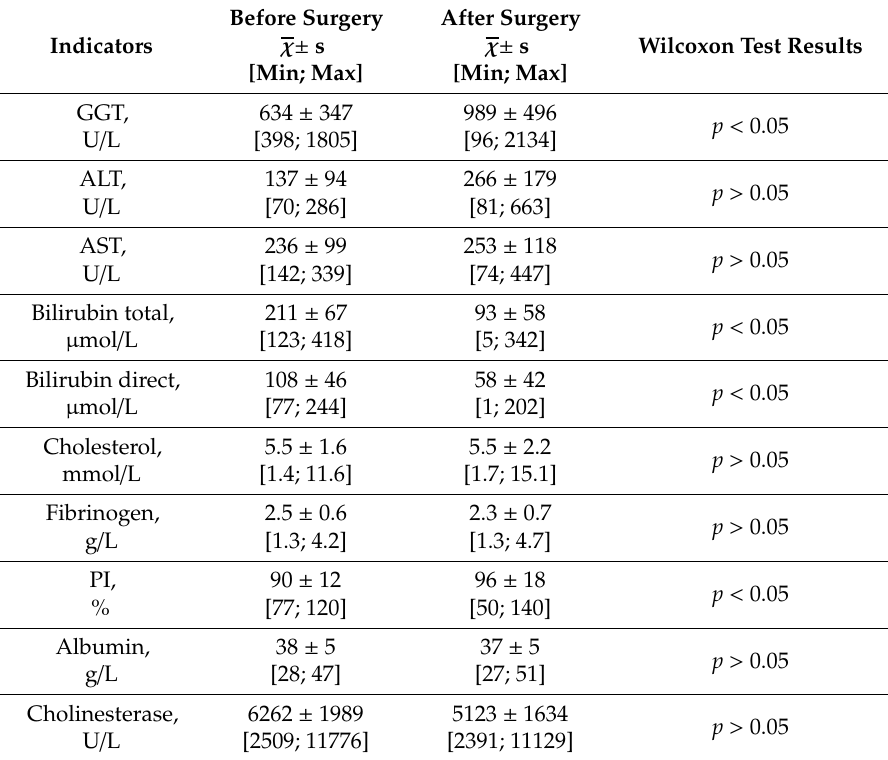
Table 1. Blood test indicators before the surgery and on day 10 p / o for patients with coloration of stools in the early post-operative period ( n =